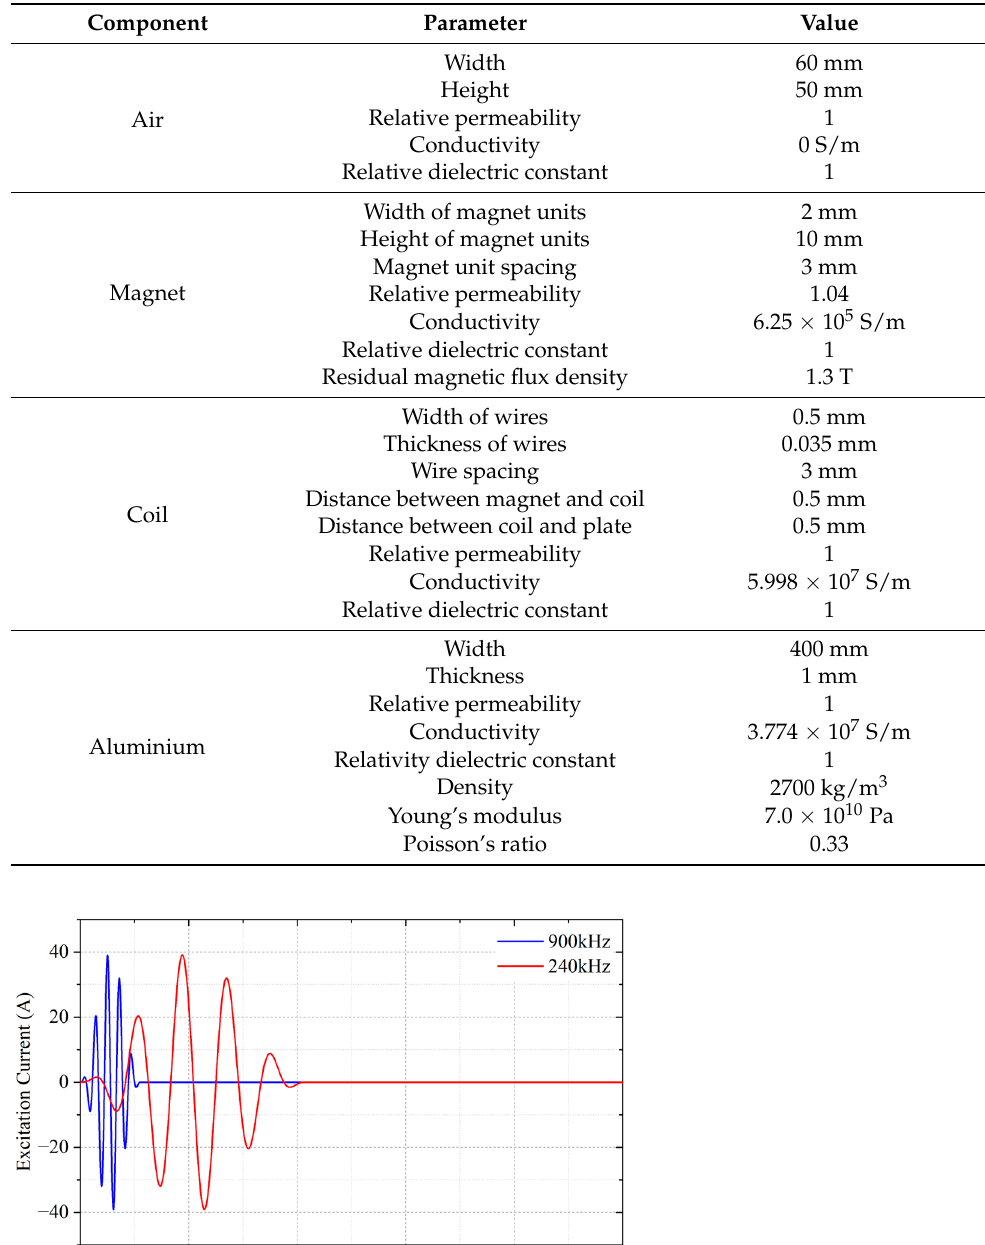
Table 1. Geometric and physical parameters of simulation models.